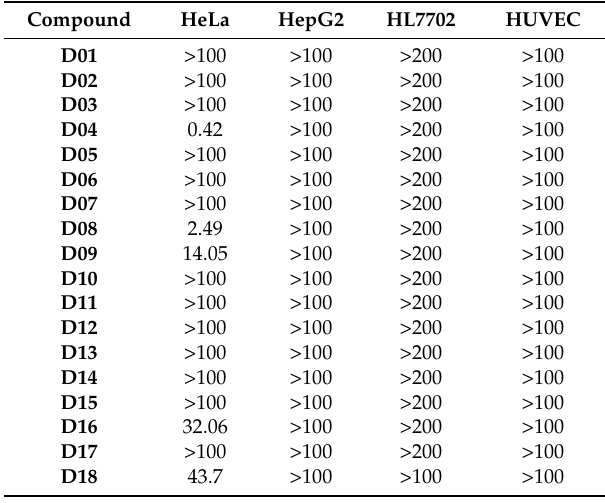
Table 2. The IC 50 ( μ mol/L) of the target compounds *.